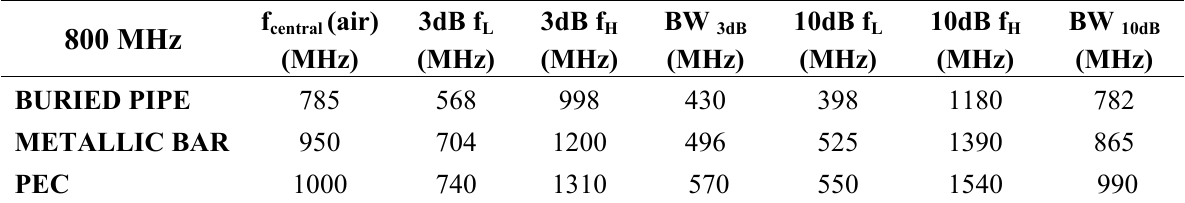
Table 2 . Frequency characteristics of the effective wavelets obtained for the 800 MHz antenna. Measurements were obtained with high stacking (512) to ensure adequate signal stability.